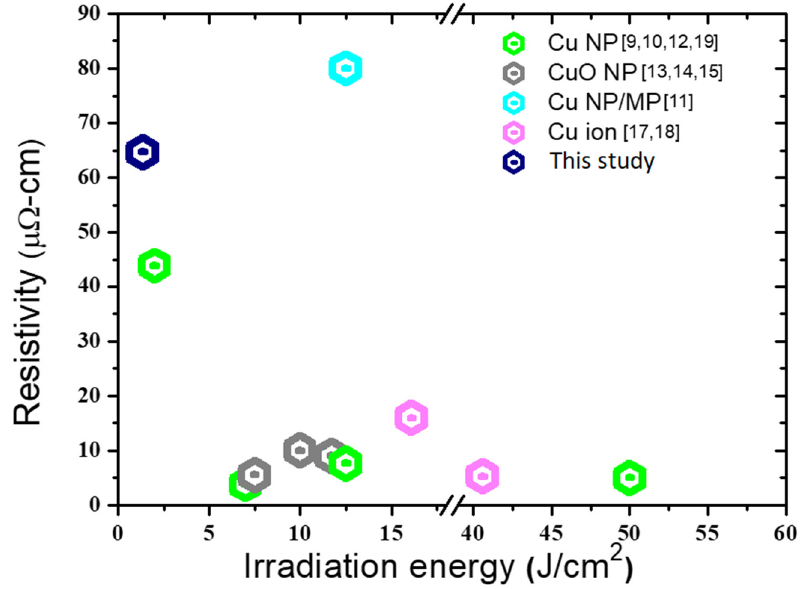
Figure 9. Materials (copper/copper oxide), flash irradiation energy and electrical resistivity of photonic-sintered structures from the literature and in this study.